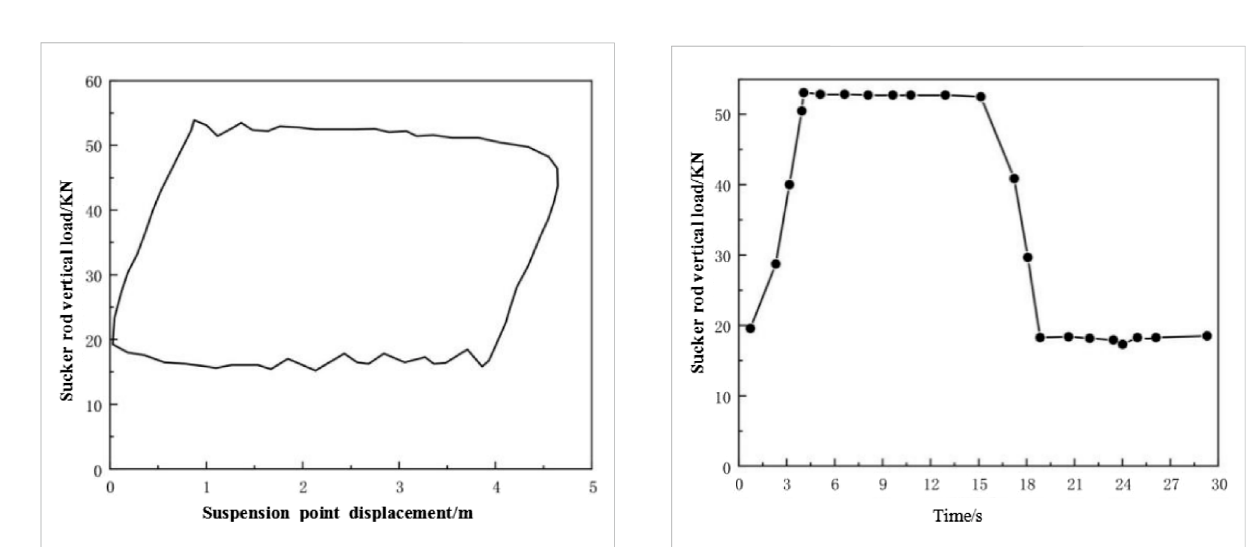
FIGURE 8 Function of the oil well.